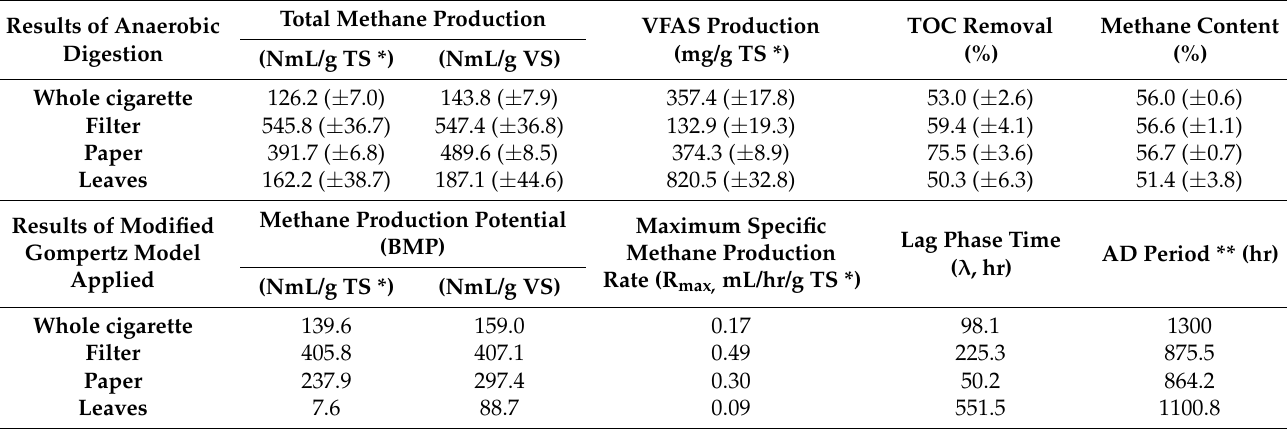
Table 1. Results of anaerobic digestion using cigarette butts or individual components and kinetic parameters calculated from the modified Gompertz model. All data are expressed as mean ± standard